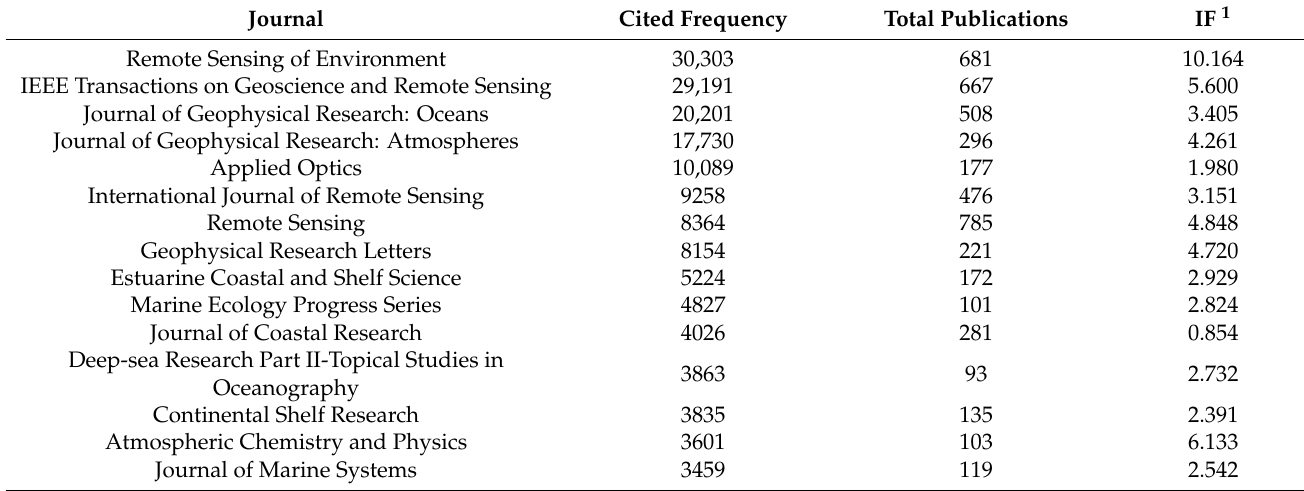
Table 1. Top 15 highly cited journals in the research